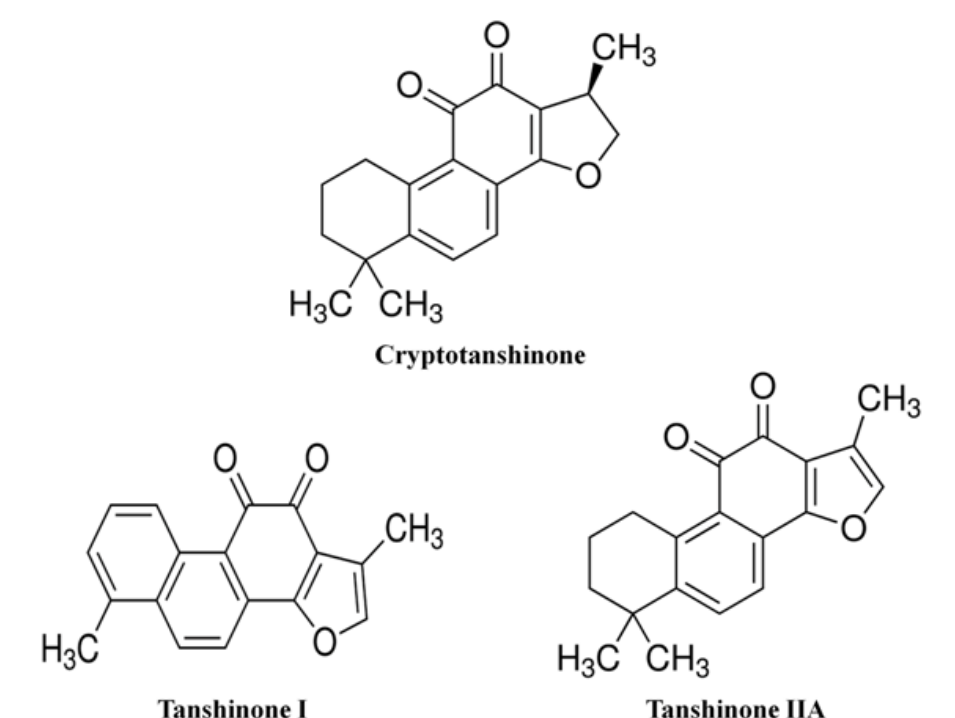
Figure 1. Structures of cryptotanshinone, tanshinone I and tanshinone